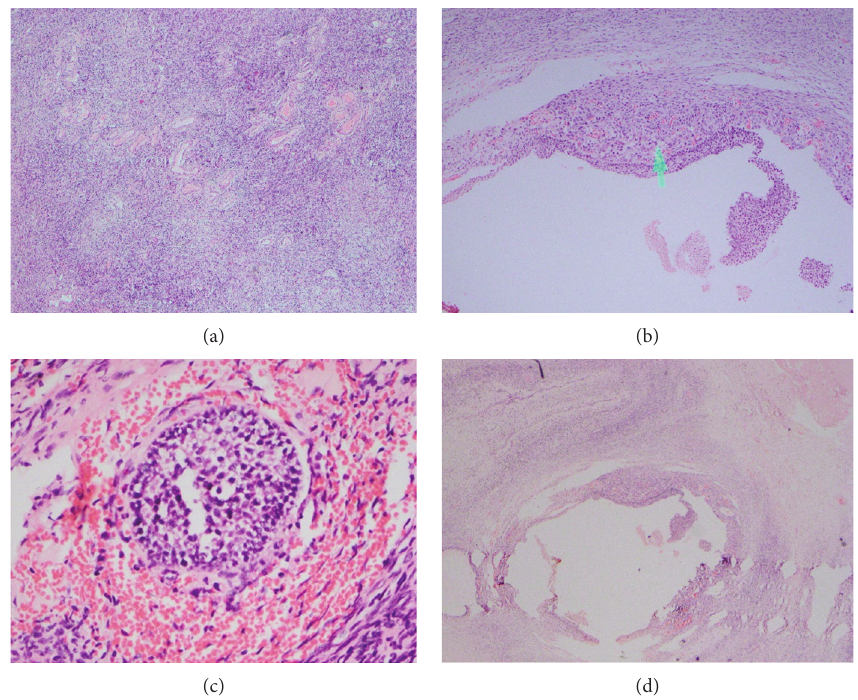
Figure 5: Right ovary histology: ovarian tissue comprises multiple ovarian follicles, some with luteinized cells. Areas of stromal hyperplasia are seen; however, luteinized cell collections are not seen. There is no evidence of hyperplasia or malignancy. Conclusion of histological features is consistent with polycystic ovary with stromal hyperplasia. (a) Stromal hyperplasia. (b) Ovarian follicle with luteinized cells. (c) Multiple follicles (400x). (d) Multiple follicles